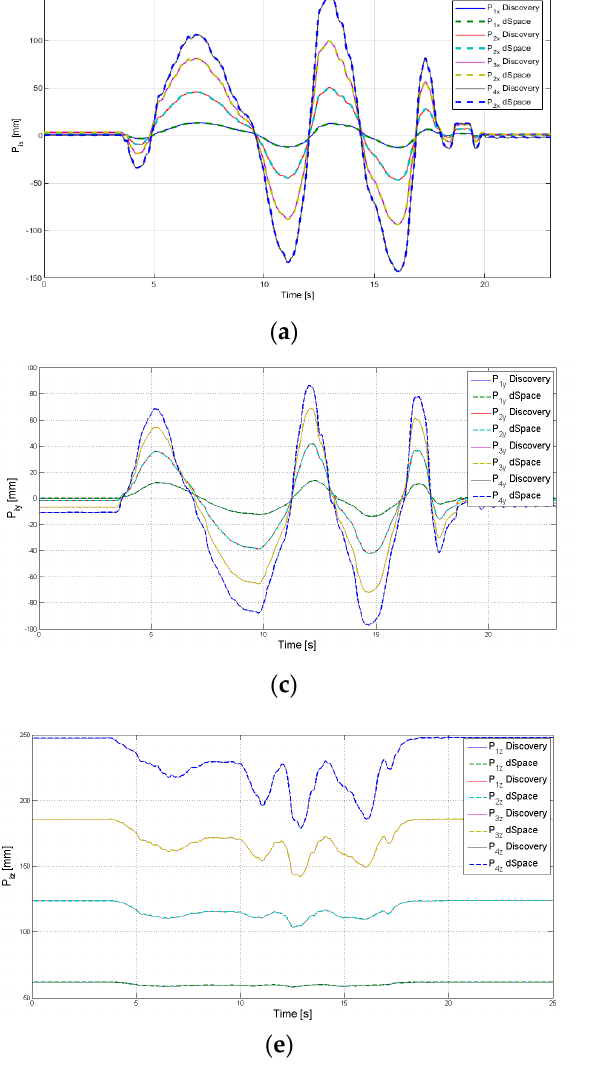
The position parameters P jx , P jy , P jz {j = 1...4} are used to reconstruct the robot shape.